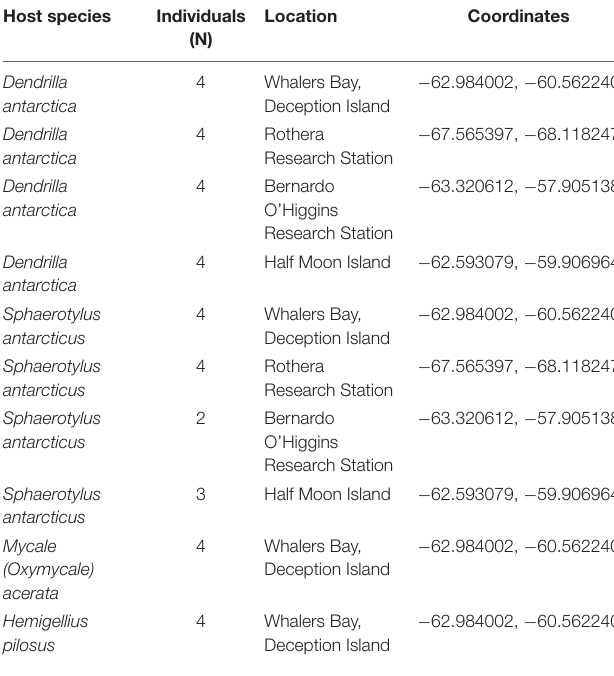
TABLE 1 | Samples of healthy specimens of Dendrilla antarctica (Topsent, 1905), Sphaerotylus antarcticus (Kirkpatrick, 1907), Mycale (Oxymycale) acerata (Kirkpatrick, 1907), and Hemigellius pilosus (Kirkpatrick, 1907) collected at 15 to 20 m depth from two South Shetland Islands (Deception and Half Moon Islands) and the Antarctic Peninsula (Rothera and O’Higgins Research